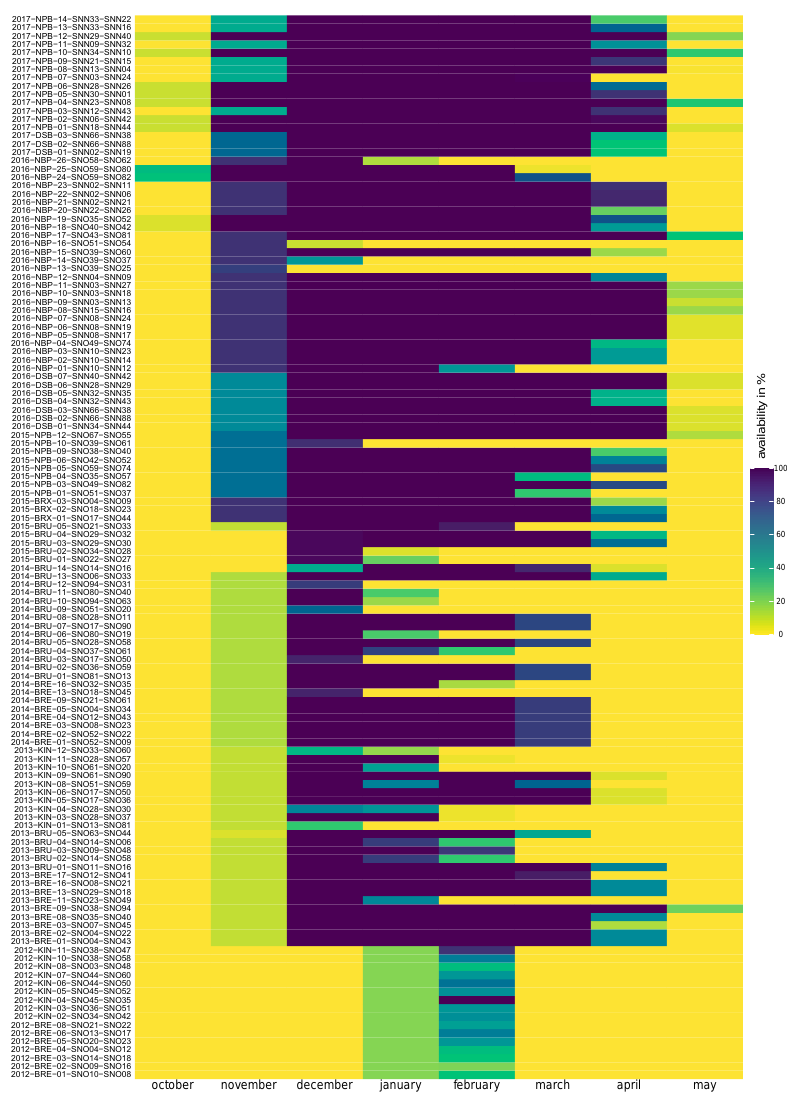
Figure A1. Availability of air temperature values for each station pair.